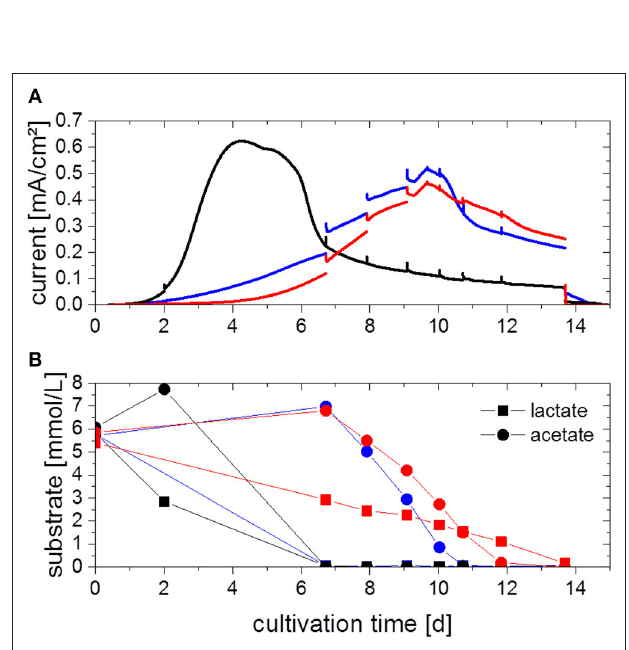
FIGURE 4 | (A) Chronoamperograms (first cultivation cycle) from defined mixed culture of G. sulfurreducens and S. oneidensis fed with 5mM acetate and 5mM lactate with (B) corresponding acetate and lactate concentration as determined by HPLC analysis. Colors refer to three parallel replicates. Anode potential: 0.2 V Ag / AgCl . Current spikes are due to sample